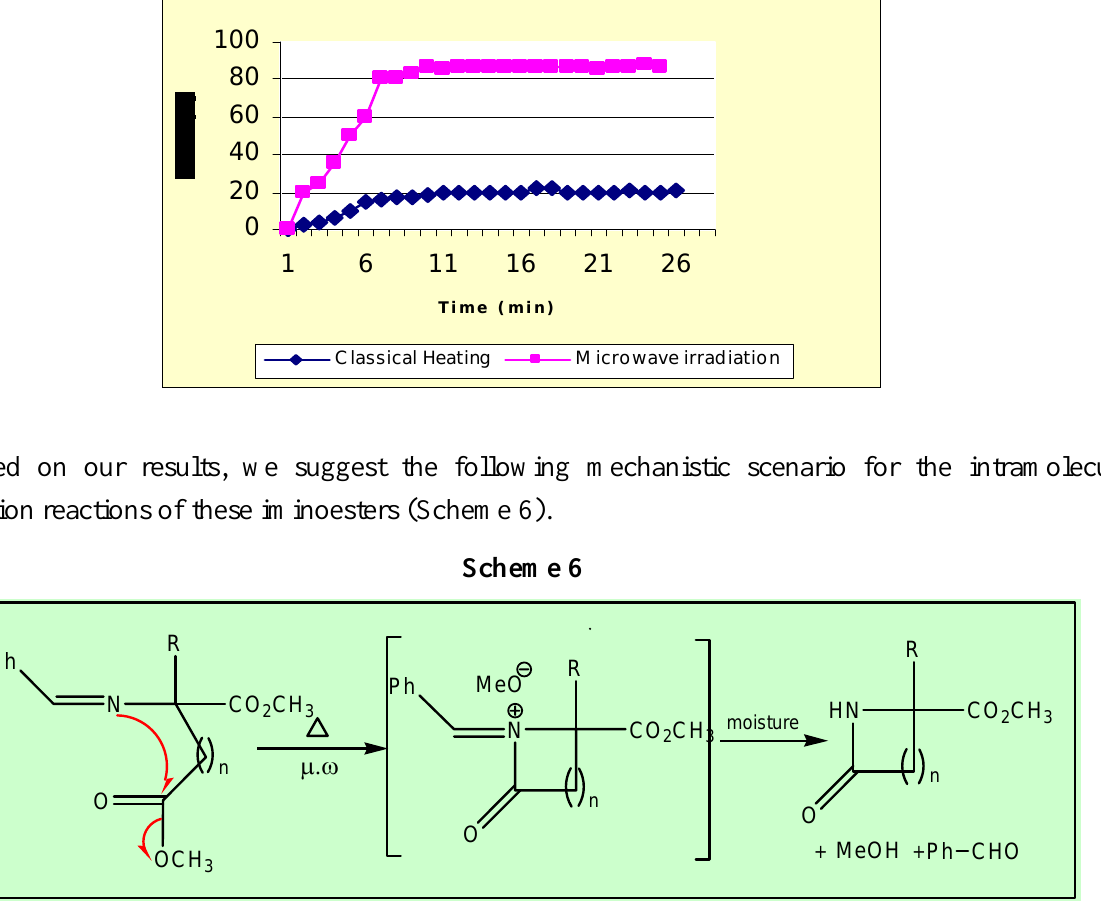
Yield versus t ime f or six membered lact am